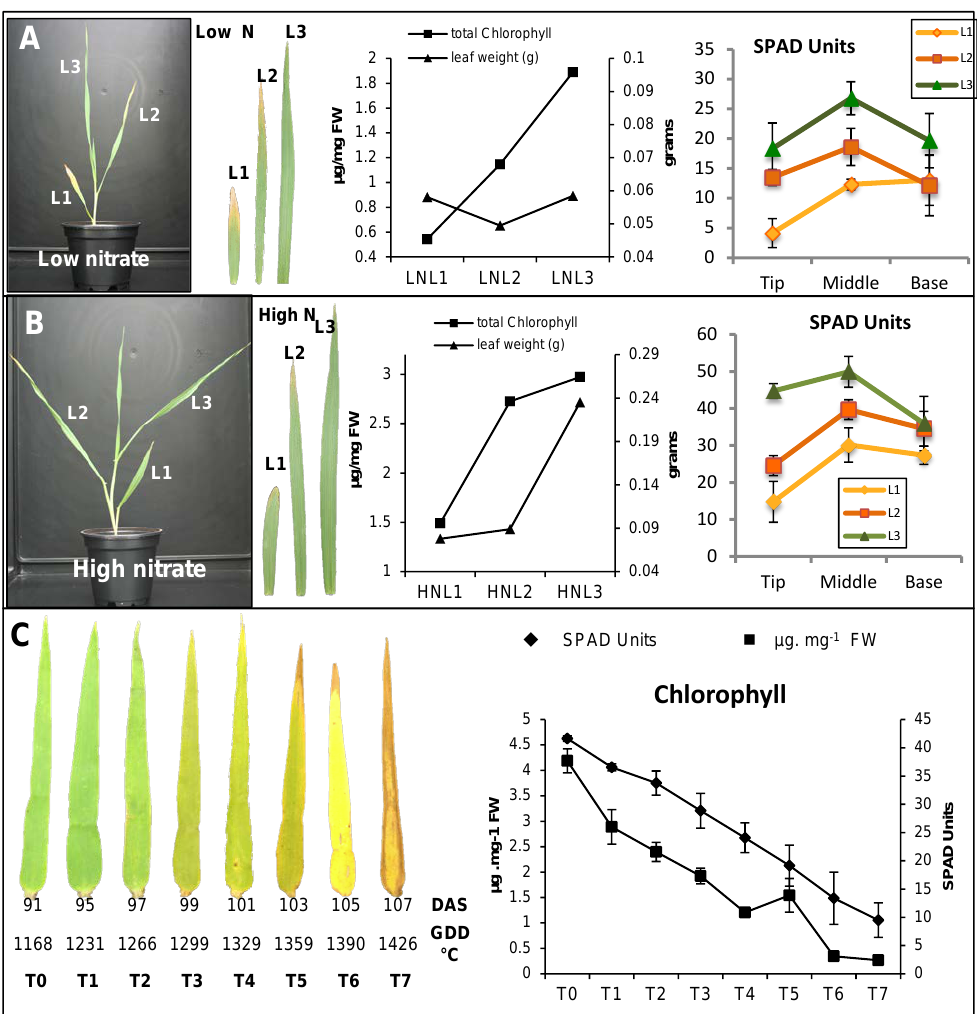
Figure 1. Natural leaf senescence in barley. Leaf senescence was monitored in primary leaves from seedlings grown under low ( A , LN) and high ( B , HN) nitrate conditions in growth chambers, and in flag leaves of plants grown in the field. Leaf ranks harvested from seedlings at 20 DAS were numbered from the oldest (L1) to the youngest (L3). Flag leaves were harvested at different time points after heading (from T0 to T7). Changes in chlorophyll contents in primary leaves were measured through spectrophotometry after extraction (black square, A , B ) (see [27]). Chlorophyll contents at the tip, middle and base of primary leaves were estimated using SPAD measurements. Chlorophyll contents in flag leaves were measured by SPAD (black circle, C ) and spectrophotometry (black square, C ). The data presented are the mean ± SD of four biological replicates. DAS (days after sowing); GDD ◦ C (growing degree days in ◦ C); T (harvesting time). Seedling experiment was performed twice showing similar